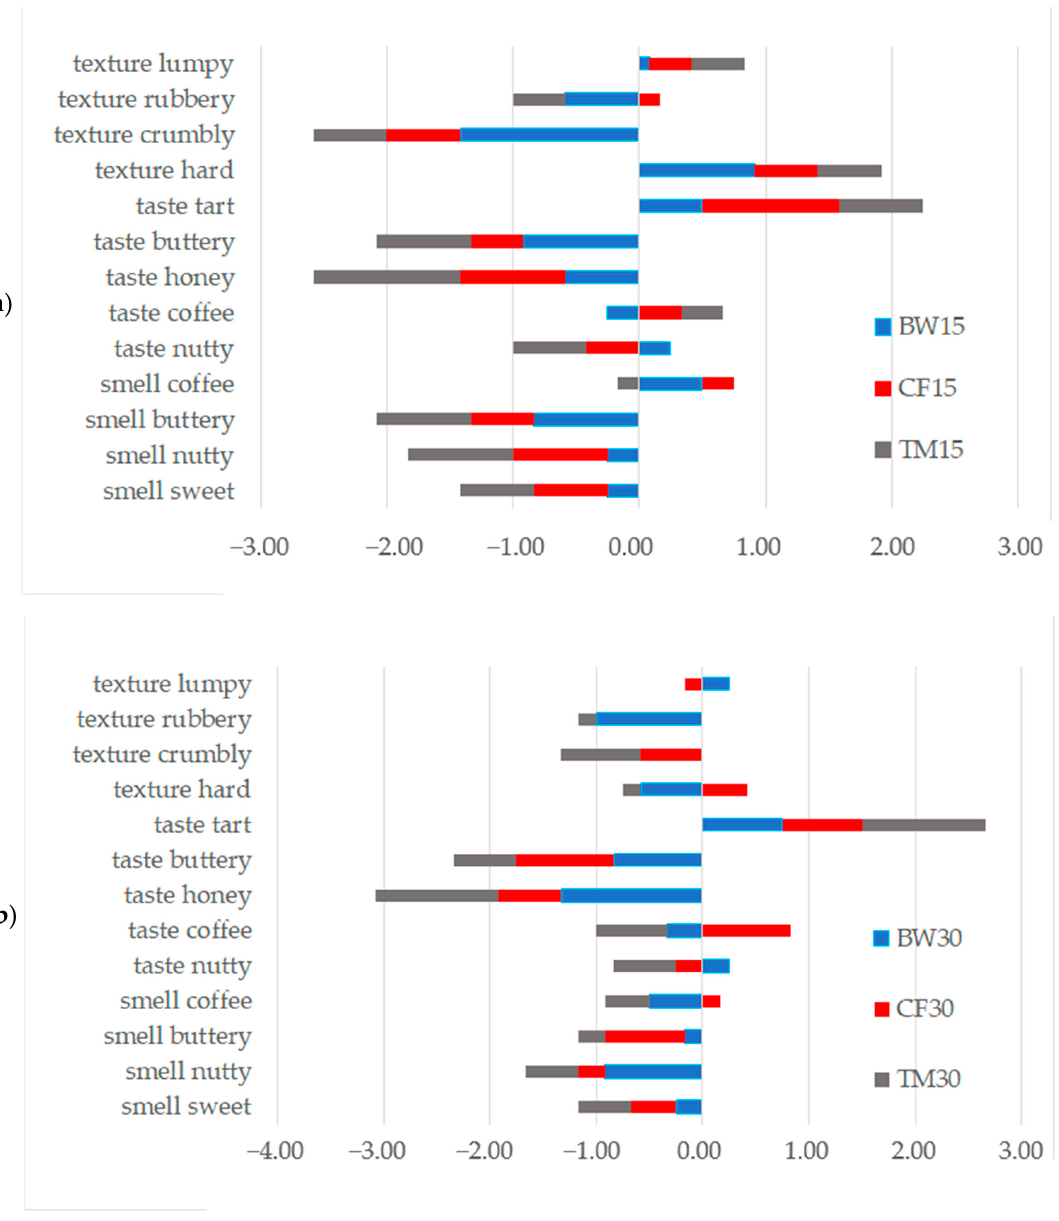
Figure 3. Directions of changes in features assessed in sensory analysis: ( a ) bars with 15% of insect fl ours; ( b ) bars with 30% of insect fl ours.